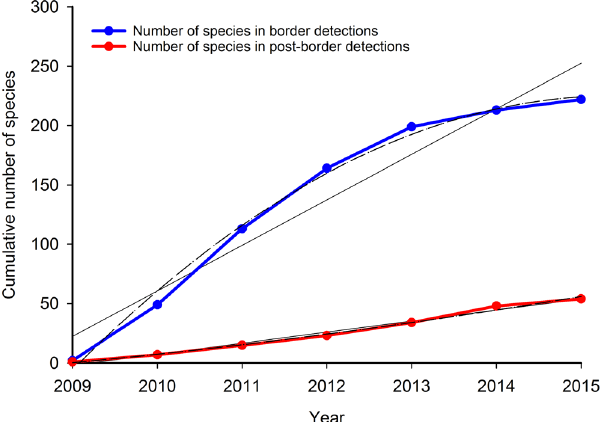
Figure 3. Cumulative number of Non Indigenous Species detected over the five years of QMS operation in border and post-border detections. The observed cumulative number of species in border detections (blue line) and post-border detections (red line), with linear (solid black), quadratic (dashed black) and cubic (dotted black) generalised linear models fitted to the number of counts per year, assuming Poisson distributed residuals. Nonlinear models were preferred in both cases, providing statistical support for a downward trend in number of species detected in more recent years. (Cubic model preferred for border detections: AIC value for linear model 157.4, quadratic 65.6, cubic 49.9; all p-values < 1.0E-3 for all models. Quadratic model preferred for post- border detections: AIC value for linear model 40.1, quadratic 32.2, cubic 37.2; all p-values < 0.03 for linear and quadratic models; all p-values > 0.05 for cubic